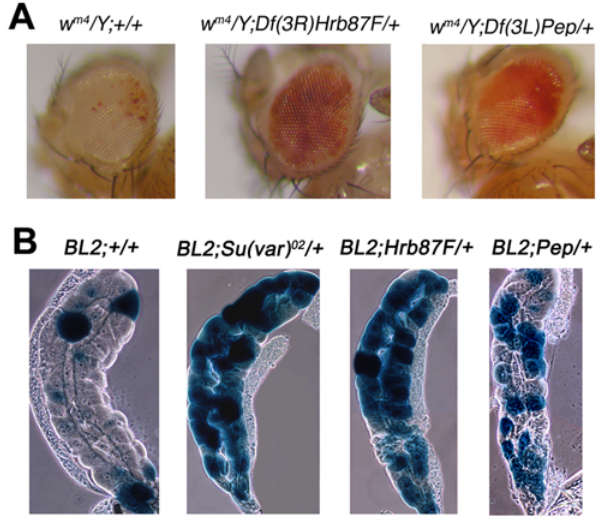
Figure 11. Hrb87F and Pep are dominant suppressors of position effect variegation (PEV). (A) In flies carrying the In(1)w m4 rearrangement and deficiencies for either Hrb87F or Pep , the eyes are significantly more pigmented than in flies carrying only the chromo- some inversion. Hrb87F KG02089 and Pep KG00294 mutations could not be tested because these mutations are caused by insertions containing a functionally wild type white gene. (B) Heat-shock lac-Z induction in salivary glands of Tp(3;Y)BL2 larvae which were also either wild type or heterozygous for Su(var)2–5 02 , Hrb87F KG02089 , Df(Hrb87F), Pep KG00294 , Pep EP(3)3357 , Pep EP(3)0408 , or Df(Pep) . The panel shows examples of staining patterns observed: in all heterozygous mutant larvae the glands stained more heavily than those of wild type